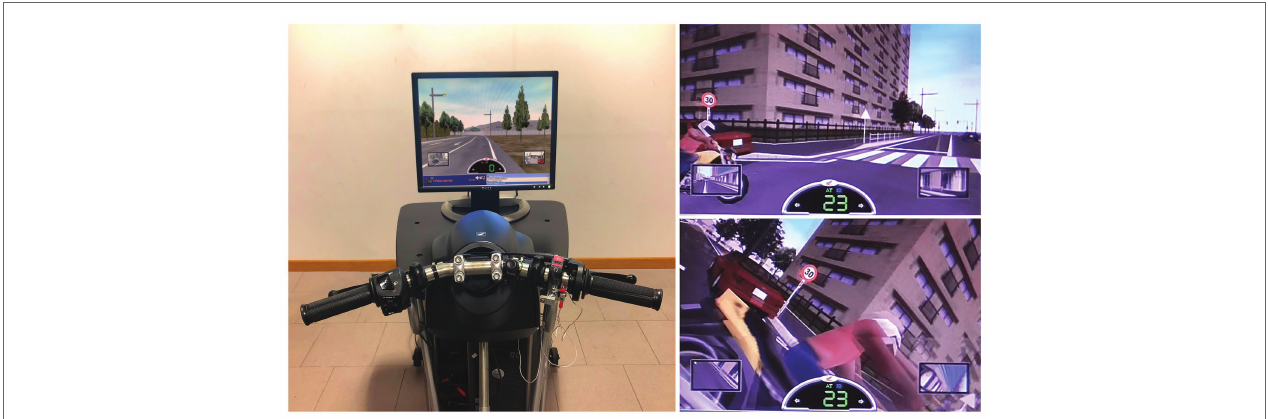
FIGURE 1 | The HRT simulator with an example of risky scene before and during the